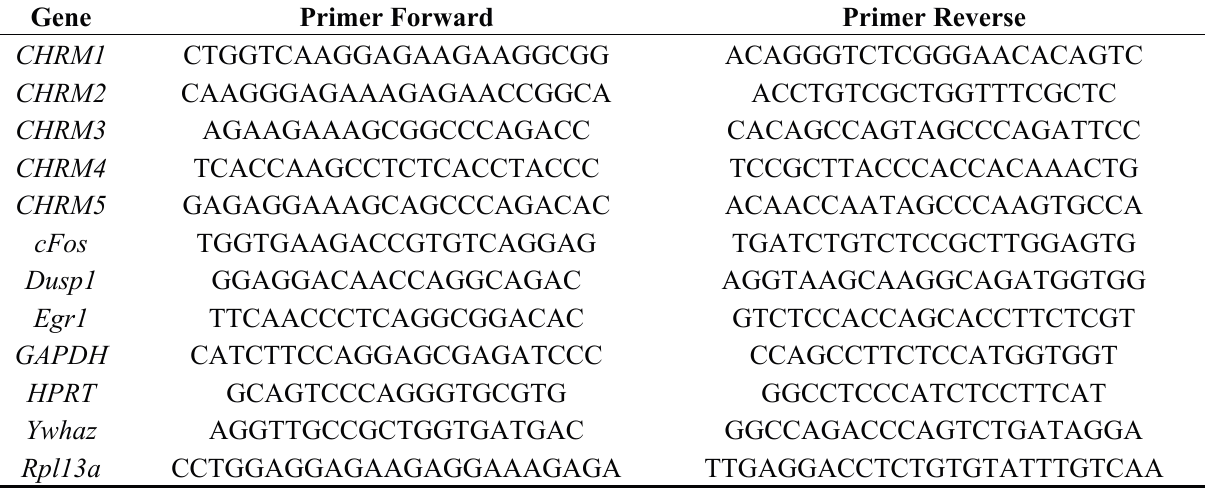
Table 1. Primer sequences for RT-qPCR primers. All sequences are given in 5'–3' direction.